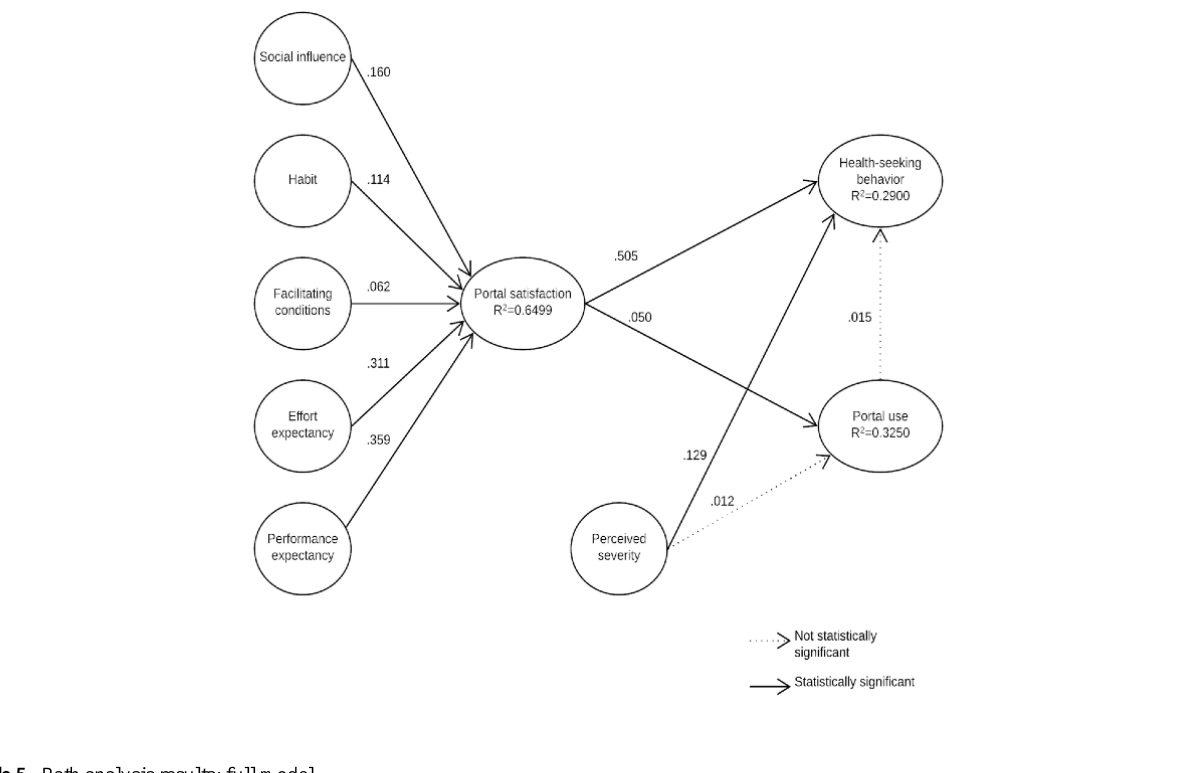
Figure 2. Empirical model with path coefficients.